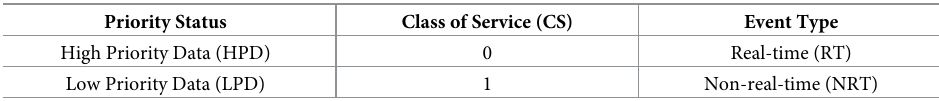
Table 1. Traffic status and prioritization